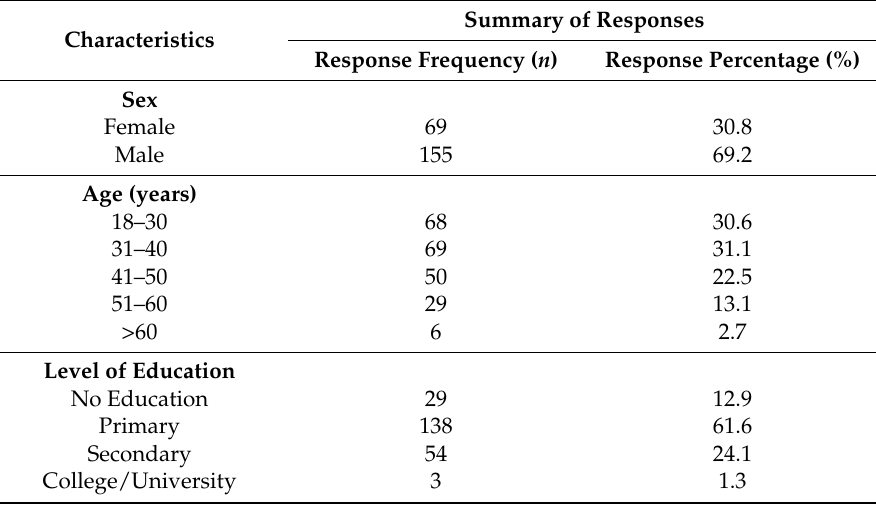
Table 1. Socio-economic profile of the respondents.